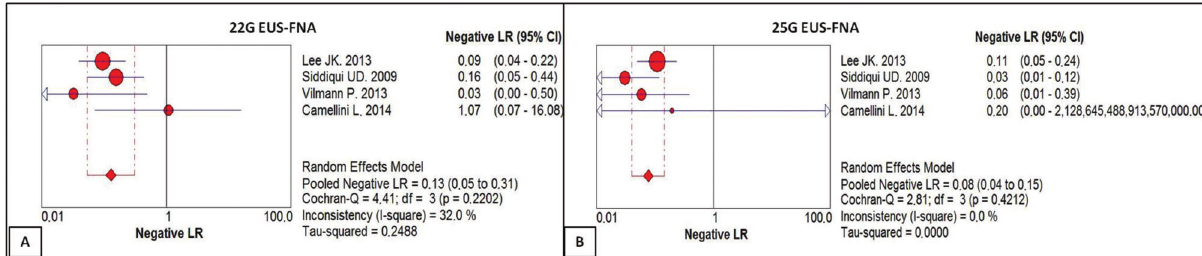
Figure 5 - (A) Negative likelihood ratio of EUS-FNA with the 22G needle. For a given prevalence of 71.61%, the negative likelihood ratio of 0.13 reduced the probability by 0.13-fold of the result being truly negative rather than false negative, with a post-test probability of -91.3%. (B) Negative likelihood ratio of EUS-FNA with the 25G needle. For a given prevalence of 77.25%, the negative likelihood ratio of 0.08 reduced the probability 0.08-fold of the result being truly negative rather than false negative, with a post-test probability of -93.85%.